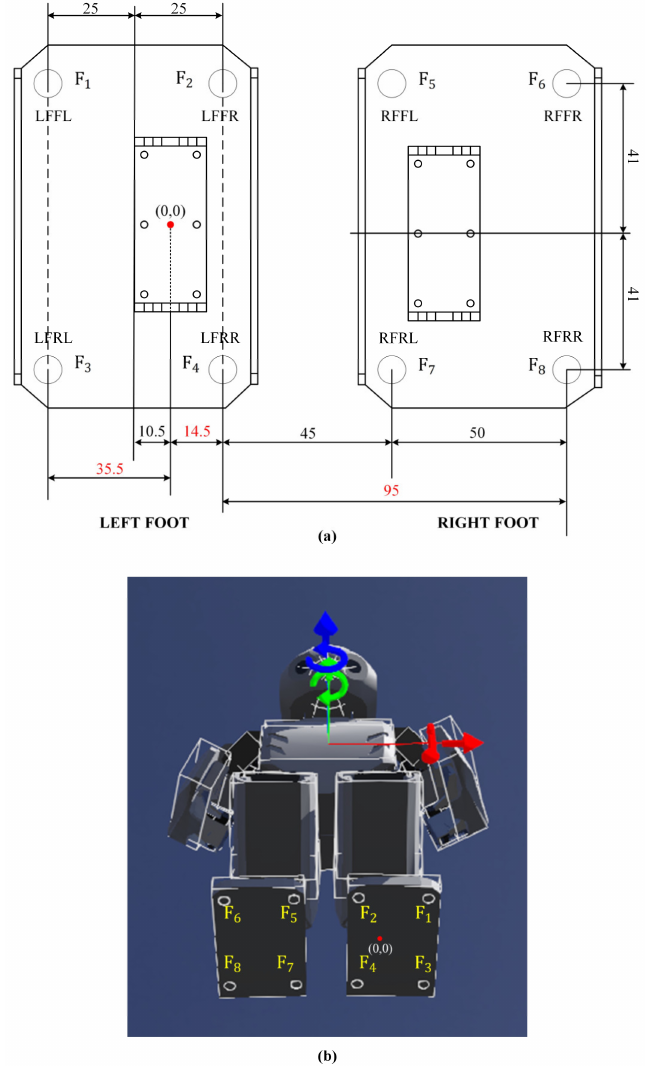
Figure 10. Robotis-OP2’s FSRs: ( a ) layout and numbering of forces (top view), ( b ) placement in